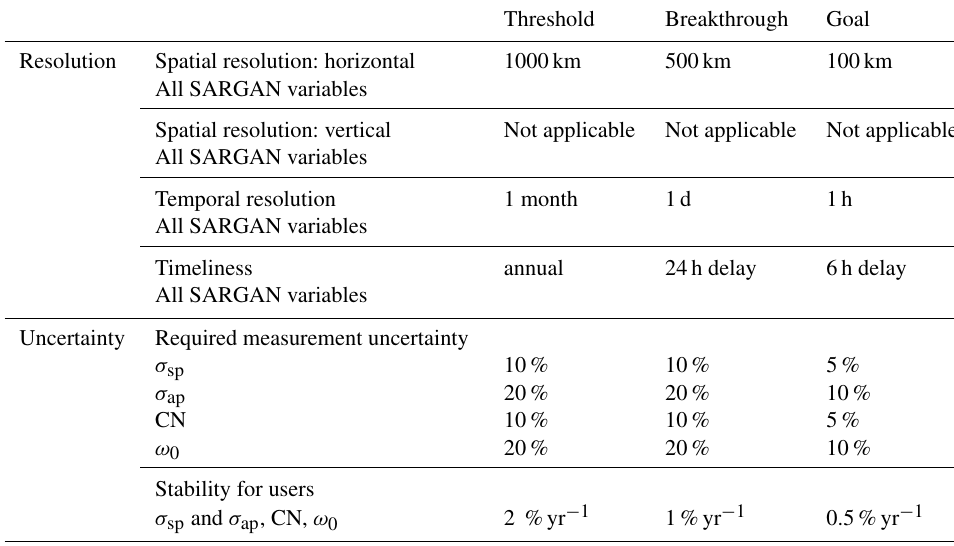
Threshold Breakthrough Goal 1000km 500km 100km Not applicable Not applicable Not applicable 1 month 1d 1h annual 24h delay 6h delay